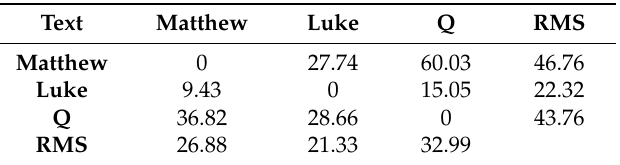
Table 13. Double Tradition and Q. Kolmogorov–Smirnov test results for 𝐼 𝑃 (below the diagonal of zeros) and 𝑀 𝐹 (above the diagonal). The values reported are the confidence level (%) that the indicated couple of probability distributions are not identical.